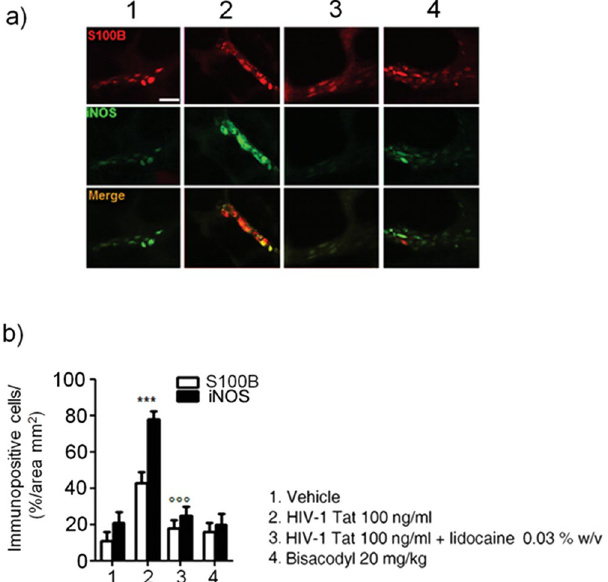
Figure 3. Intracolonic administration of HIV-1 Tat (100 ng/ml) yields to a marked activation of submucosal plexus-EGCs, as shown by the immunofluorescence analysis showing a significant increase of S100B and iNOS protein co-expression. ( a ) The panel shows iNOS (green) and S100B (red) immunoreactivity with ( b ) the respective quantification of iNOS (filled bars) and S100B (open bars) expression in the EGCs; both lidocaine pretreatment and bisacodyl administration failed to significantly affect S100B/iNOS expression. Results are expressed as mean ± SEM; *** p < 0.001 vs all other groups; °°°p < 0.001 vs HIV-1 Tat group. Scale bar: 20 μ m.